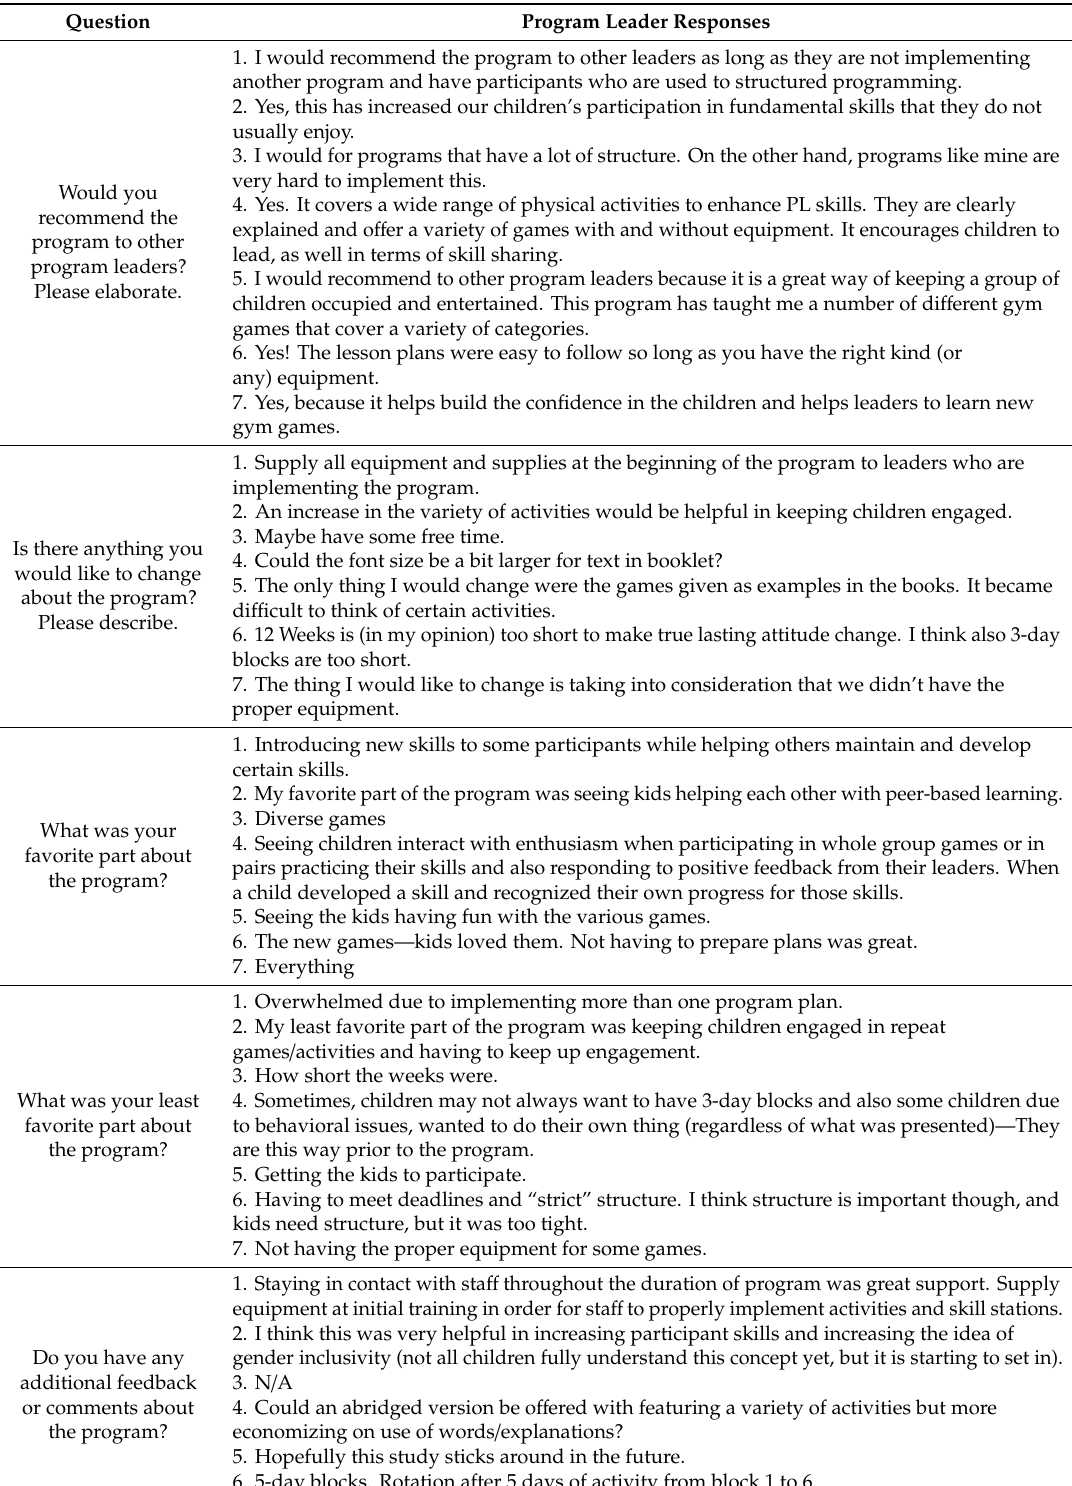
Table 6. Post-intervention feedback from the program